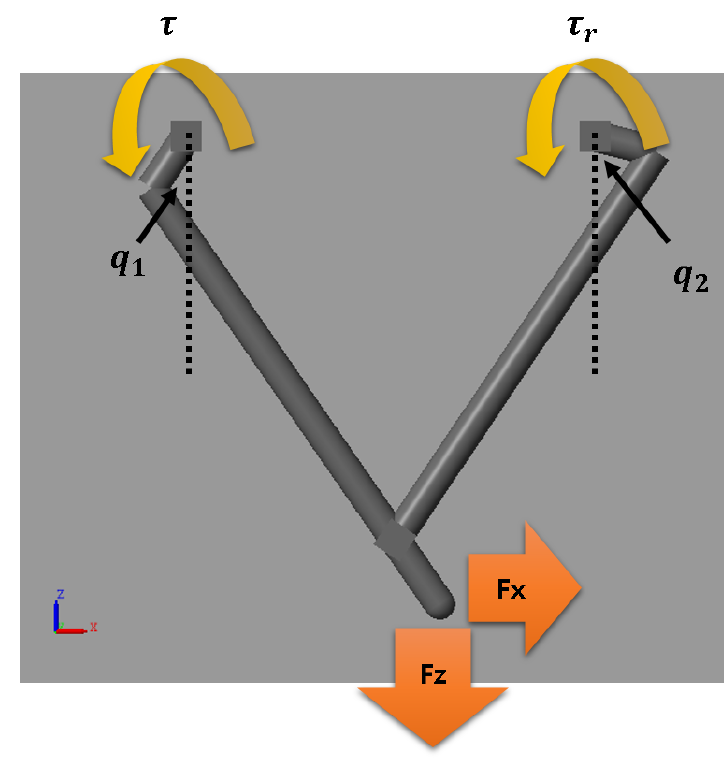
Figure 2. Leg model for neural network